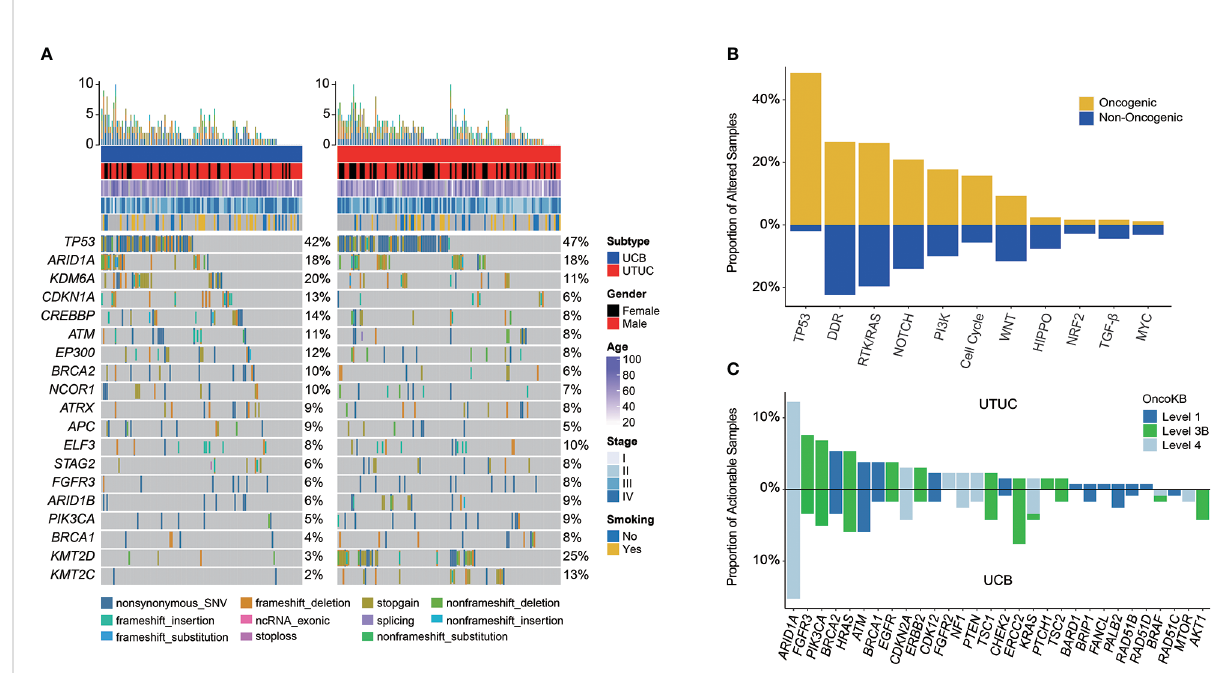
FIGURE 1 Pro fi ling of prevalent somatic and actionable alterations in Chinese UTUC and UCB. (A) Comparison of the most prevalently altered genes between Chinese UTUC and UCB. (B) Oncogenic canonical pathways in Chinese UC. (C) Comparison of actionable alterations between Chinese UTUC and UCB. UTUC, upper tract urothelial carcinoma, UCB, urothelial carcinoma of the